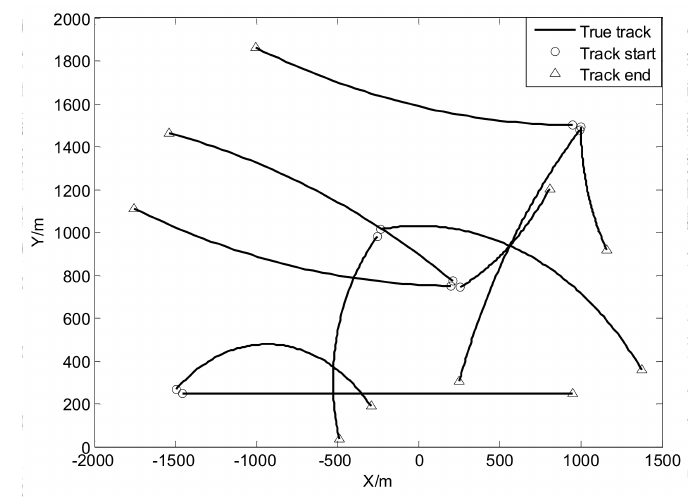
Figure 8. True trajectories of each target.